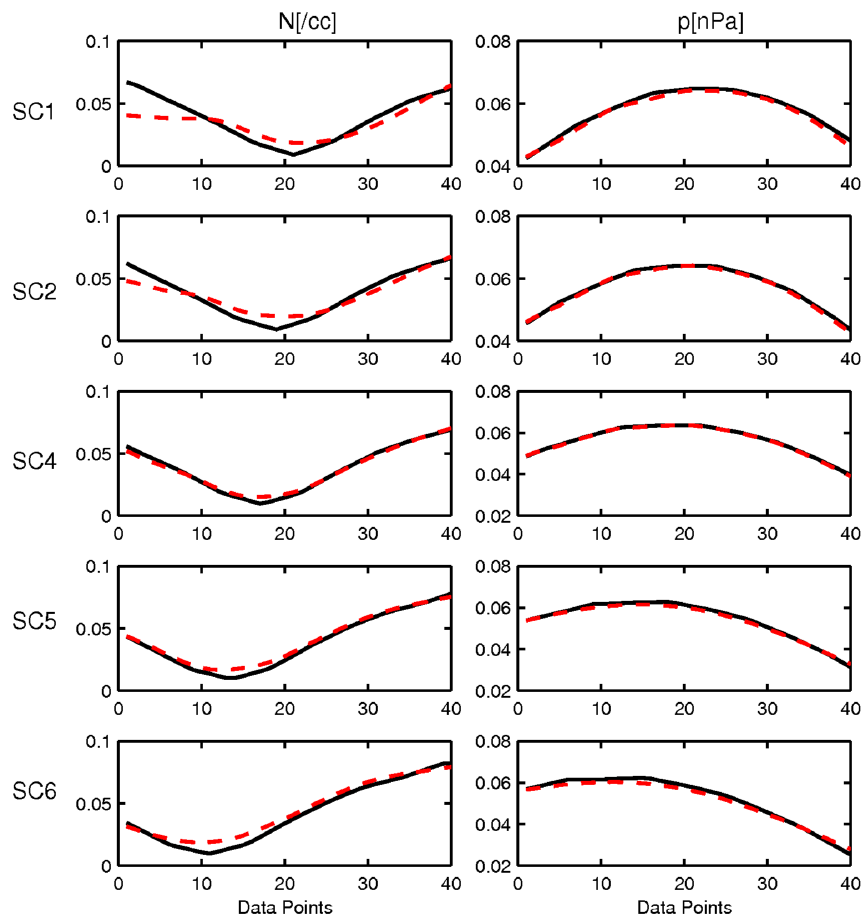
Figure 9. Snapshot plots of the predicted plasma density N and pressure p (red dashed lines) from the reconstruction map based on spacecraft 3 and the corresponding values (black lines) taken by the other spacecraft directly from the simulation.